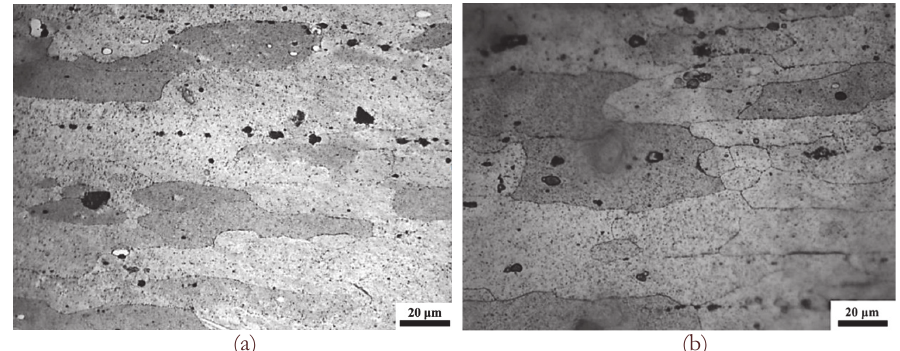
Figure 2: Microstructures of (a) HAZ at a distance 12mm from the weld centerline, (b) A200 material.